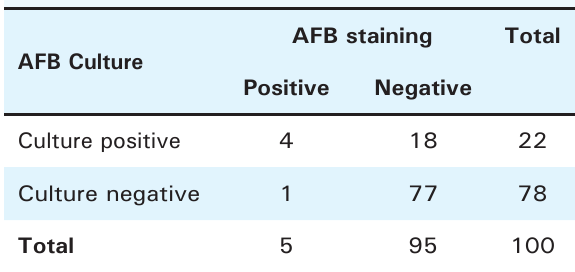
Table 2. Modalities of Diagnosis